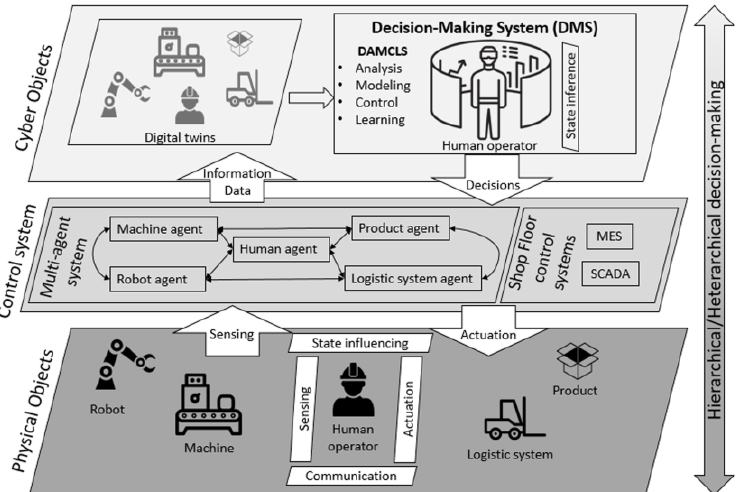
Figure 5. Social cyber-physical manufacturing system architecture integrating humans into the loop (see [45]).